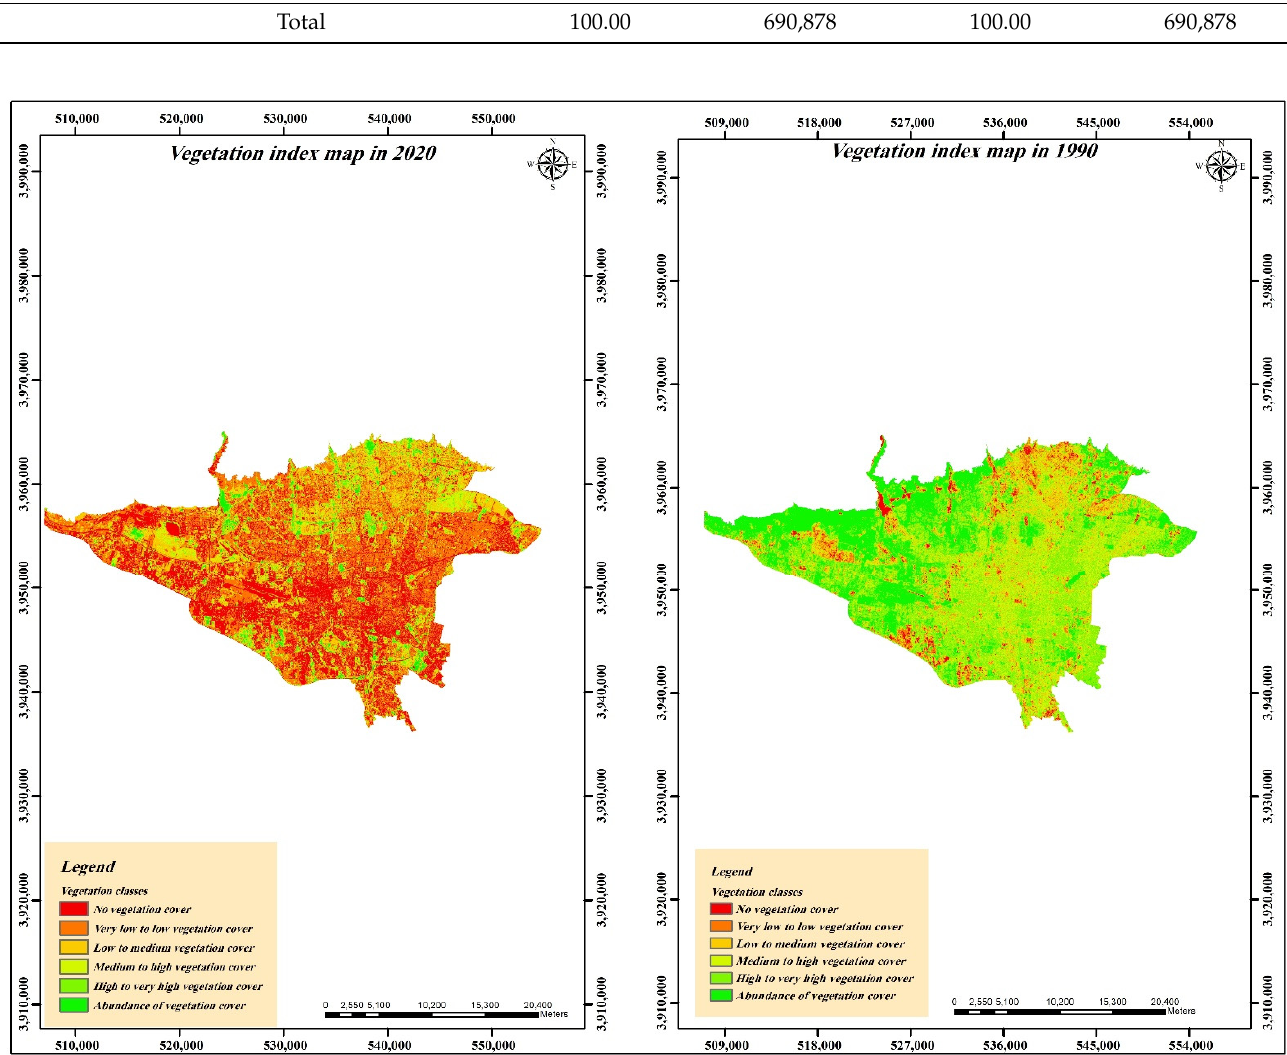
Figure 3. Vegetation index map of Tehran metropolis in 1990 and 2020. High to very high vegetation cover (34.46%) accounted for the highest share of cells, followed by abundance of vegetation cover (28.17%). The lowest share was occupied by no vegetation cover (with 1.77%), followed by very low to low vegetation cover (4.57%). The abundance of vegetation cover class was mainly concentrated in the northern and north-western parts of the Tehran metropolis. Over the past three decades, the study area has shifted from green lands to lands without green cover. In other words, the expansion of the built environment has